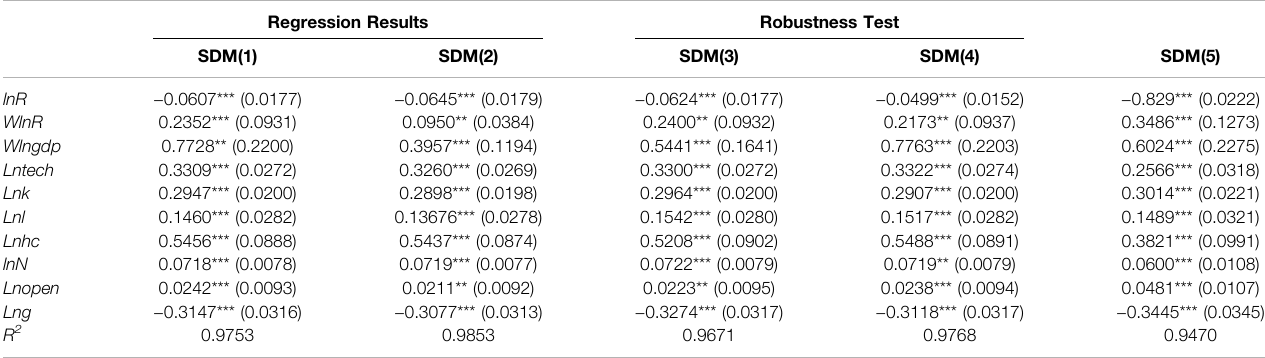
TABLE 4 | Regression results of the total sample and robustness